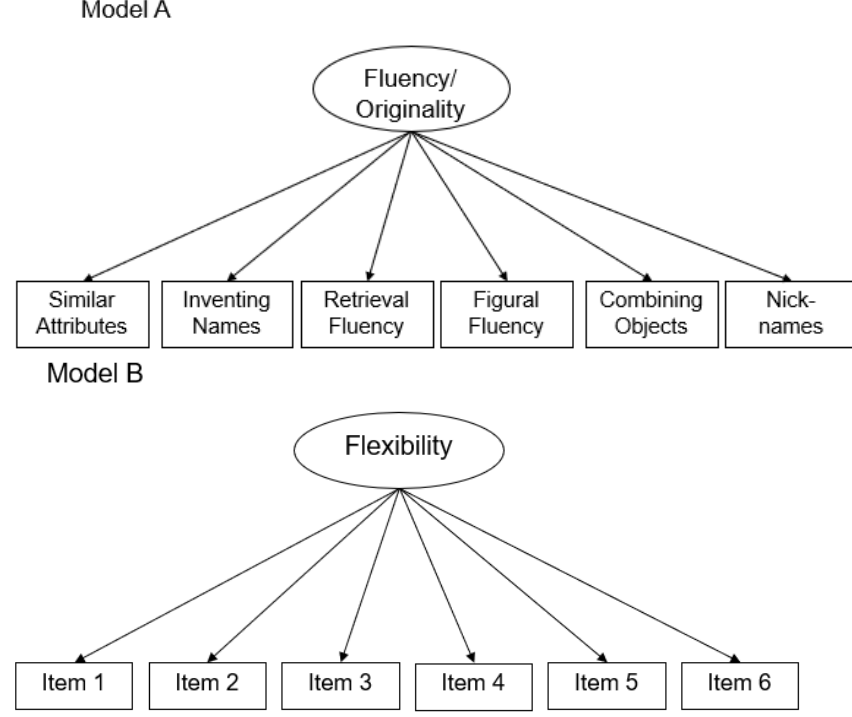
Figure 1. Schematic measurement model of fluency/originality (Model A) and flexibility (Model B).